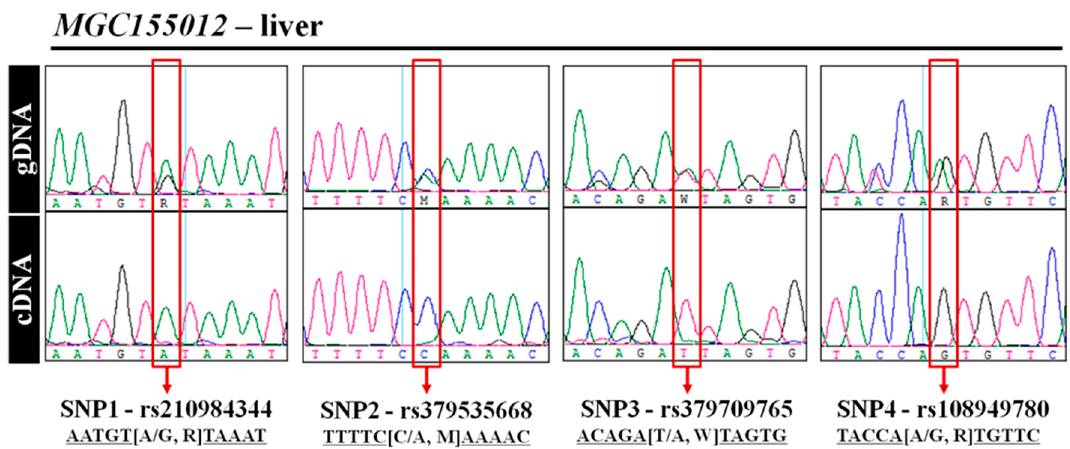
Figure 3. Representative sequence chromatogram for allele-specific expressions of four single nucleotide polymorphisms (SNPs) of MGC155012 in liver. In each SNP locus, gDNA is heterozygous and cDNA, which was synthesized from RNA, is homozygous.